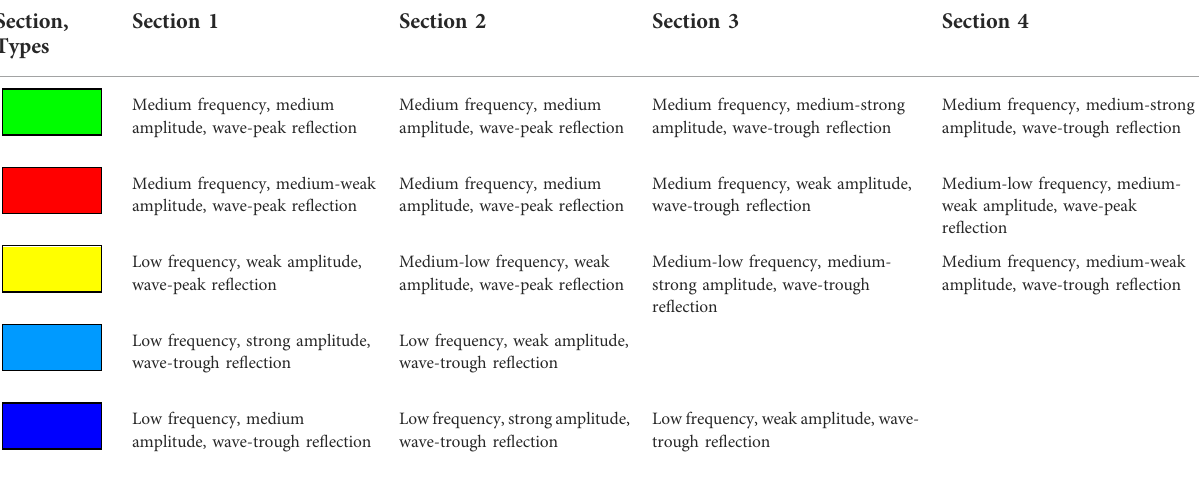
TABLE 2 Correspondence between seismic facies types and seismic re fl ection characteristics in the Shan-2 Lower